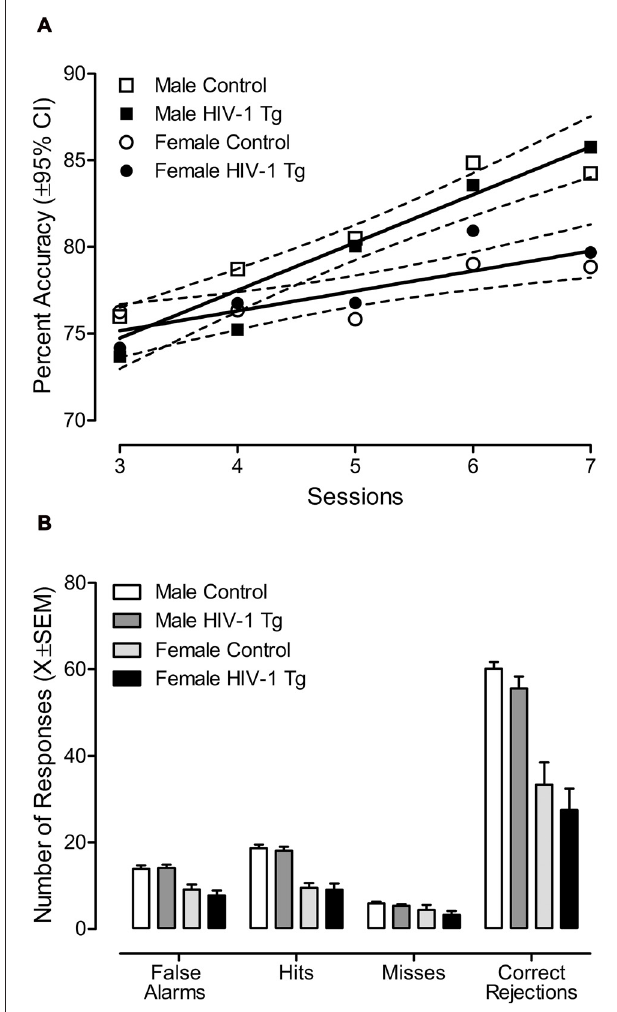
FIGURE 3 | Once animal’s met criterion in the final signal detection task, the factor of biological sex had a significant effect on percent accuracy and an animal’s response profile. (A) Both male and female animals, regardless of genotype, exhibited a linear increase in percent accuracy across test sessions. However, the rate of increase in percent accuracy occurred more slowly in female animals relative to male animals. (B) Female animals displayed a decreased response rate relative to male animals on all response types (i.e., false alarms, hits, misses and correct rejections). There was no compelling evidence for any effect of the HIV-1 transgene on either percent accuracy or an animal’s response profile once the task was well